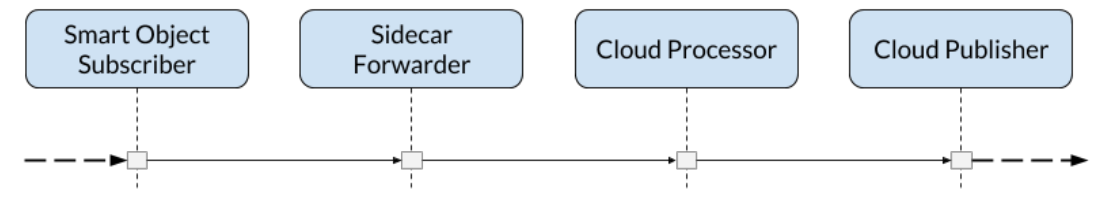
Figure 4. Data messages handling in the case of simple forwarding.